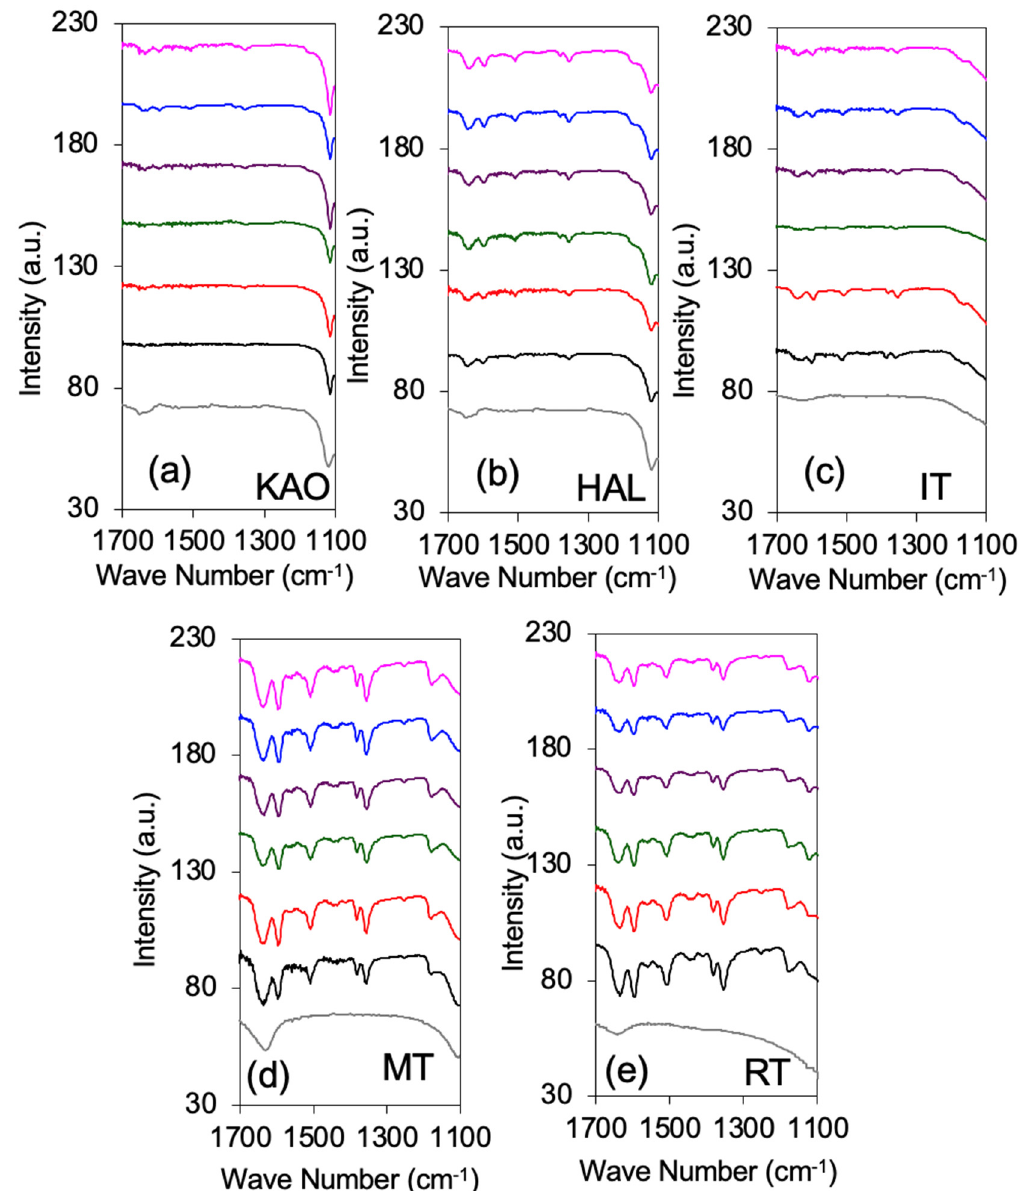
Figure 7. FTIR spectra of KAO ( a ), HAL ( b ), IT ( c ), MT ( d ), and RT ( e ) showing wavenumbers of 1100–1700 cm − 1 . From bottom up, the initial AO concentrations were 0, 0.5, 1, 2, 3, 4, and 5 mM for KAO, HAL, IT, and RT, and 0, 1, 2, 4, 6, 8, and 10 mM for MT. The labels for band position in the figure ( e ) refer to the locations of original AO bands. See Table 2 for the shift of the bands.